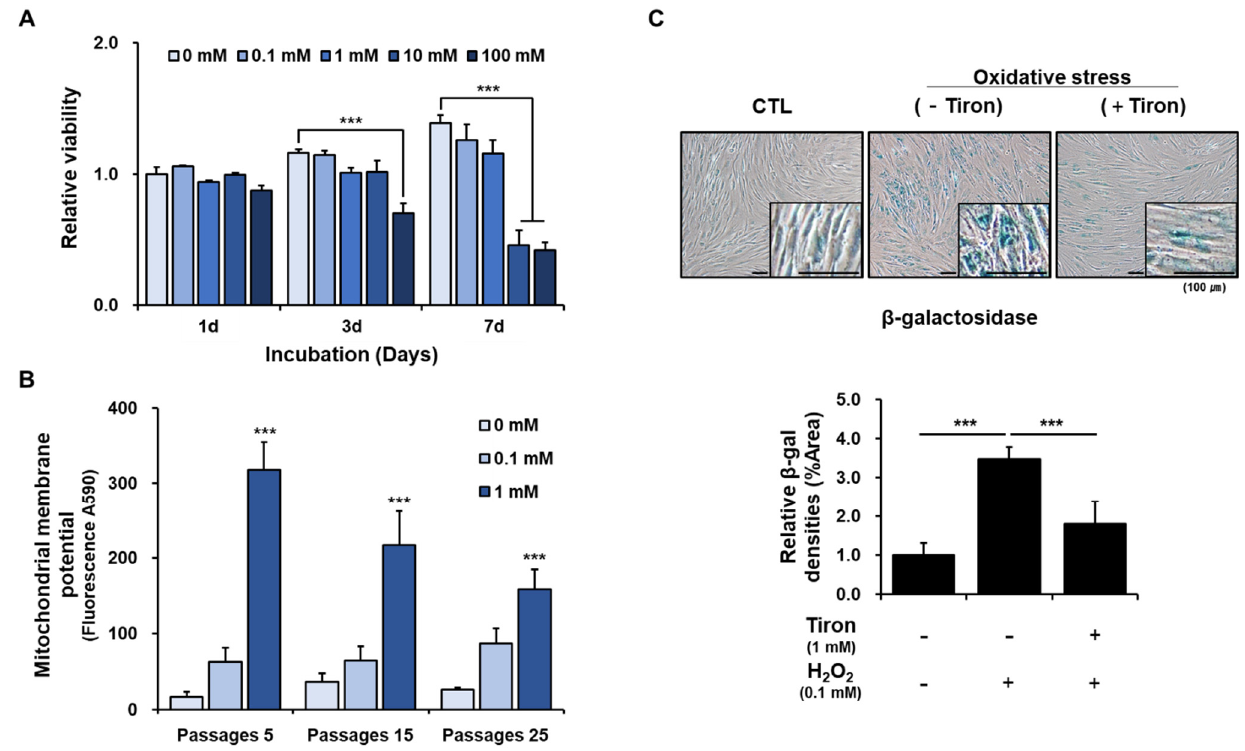
Figure 1. Biological activity of tiron in hPDCs. ( A ) The viability of hPDCs was unchanged after culture with 1 mM tiron compared to that of control cells. ( B ) Treatment with 1 mM tiron significantly increased the MMP in hPDCs, regardless of the passage. ( C ) Treatment with 1 mM tiron clearly decreased H 2 O 2 -induced β -galactosidase activity in hPDCs. (*** p < 0.001) .